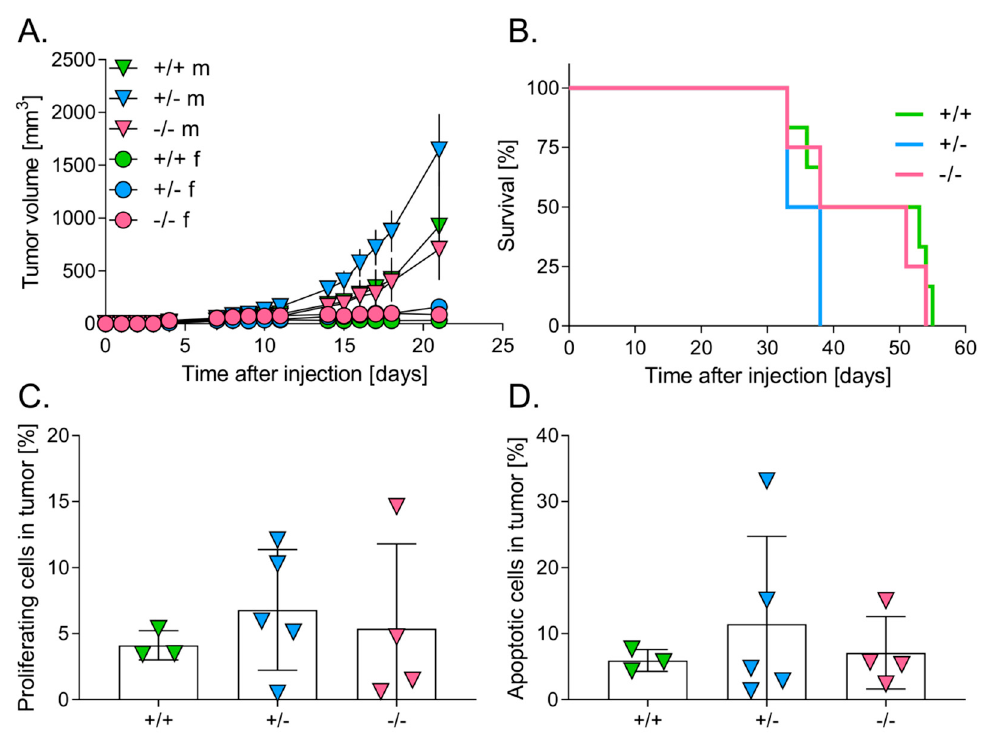
Figure 1. E ff ect of Heme oxygenase-1 (HO-1) expression in mice on survival and primary tumor growth. ( A ) Tumor volume in males (m) ( N = 4–10) and females (f) ( N = 4–10) of di ff erent HO-1 genotype: +/+ , +/ − or − / − . ( B ) Survival of males ( N = 4–6). ( C ) Percentage of proliferating cells (proliferating cell nuclear antigen (PCNA) / DAPI-positive cells). ( D ) Percentage of apoptotic cells (TUNEL / DAPI-positive cells). Each point represents mean ± SE ( N =